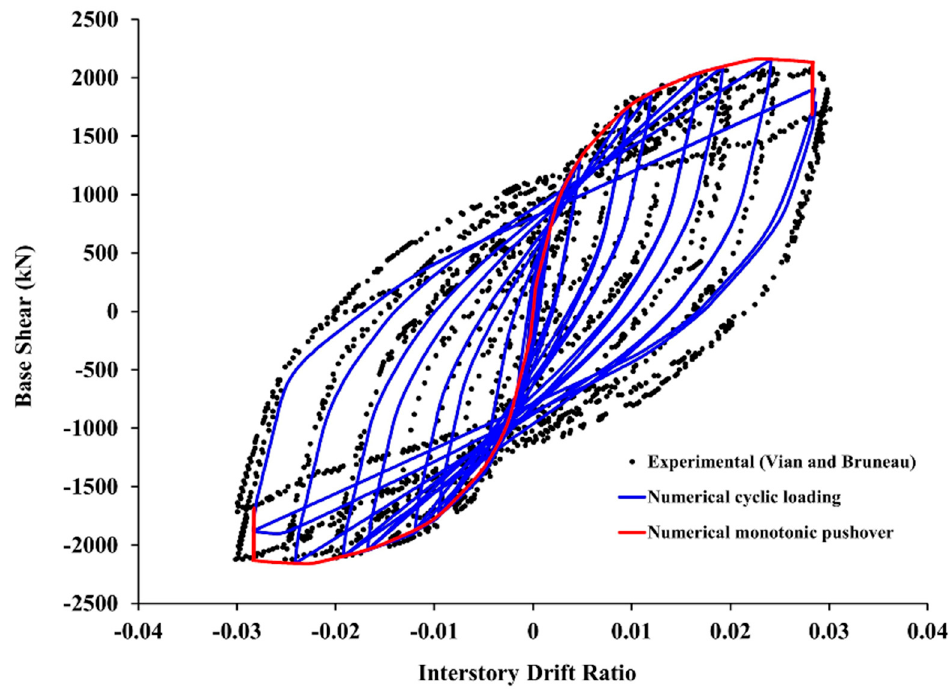
Figure 9. Comparison between numerical and experimental pushover curves for the single-story specimen by Vian and Bruneau [54]. specimen by Vian and Bruneau